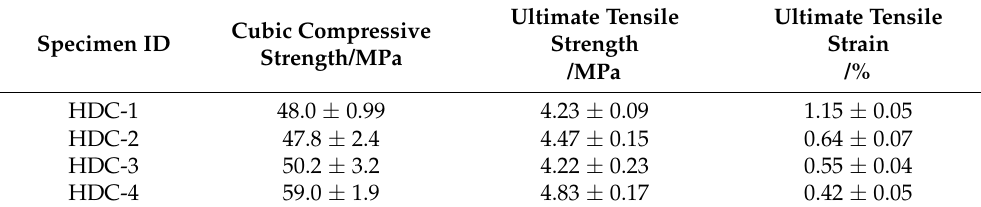
Table 4. Mechanical properties of four different HDC mixtures.